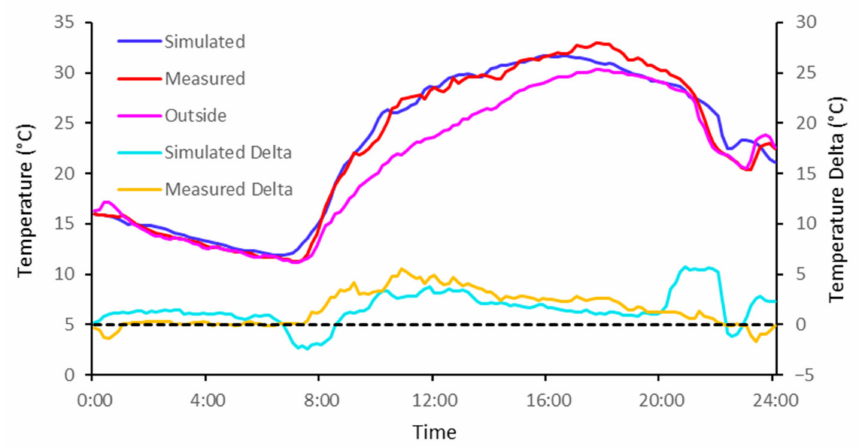
Figure 6. Simulated versus measured temperatures inside a high tunnel on 13 July 2019. The simulated and measured temperatures were compared to the measured outside temperature and expressed as differences (delta).